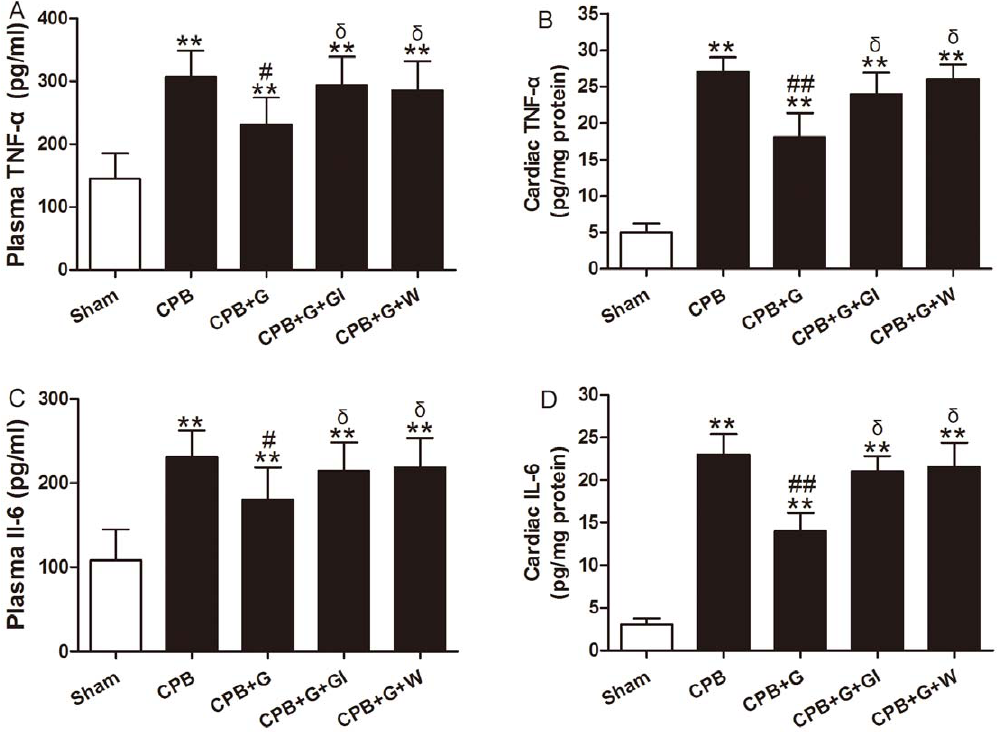
Figure 4. Serum (A) and cardiac (B) tumor necrosis factor (TNF)- a and Serum (C) and cardiac (D) interleukin (IL)-6 production in rats subjected to CPB with different treatments (n=8/group). Values presented are mean 6 SEM. G, ghrelin; GI, [D-Lys3]-GHRP-6, ghrelin inhibitor; W, wortmannin, a PI3K inhibitor. ** P , 0.01 vs. Sham, ## P , 0.01 vs. CPB, # P , 0.05 vs. CPB, d P , 0.05 vs. CPB + G.